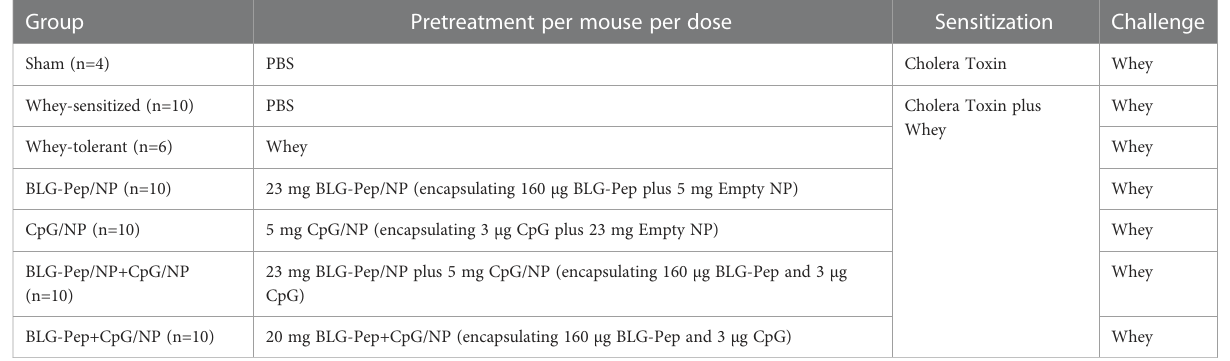
TABLE 1 Treatment groups of the animal study in the CMA prevention murine model. Group Pretreatment per mouse per dose Sensitization Challenge